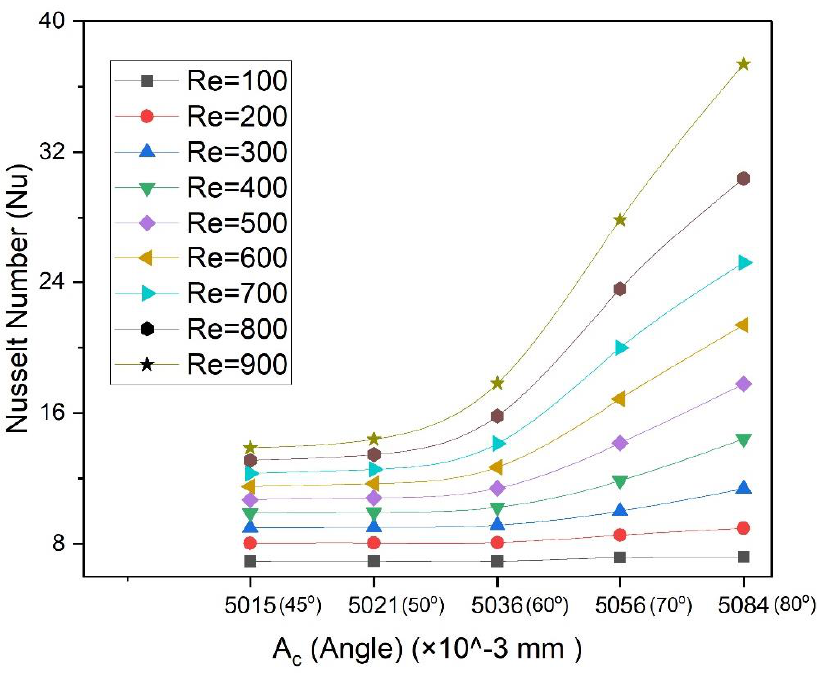
Figure 11. Dependence between Nusselt number and heat transfer area for different Reynolds numbers.